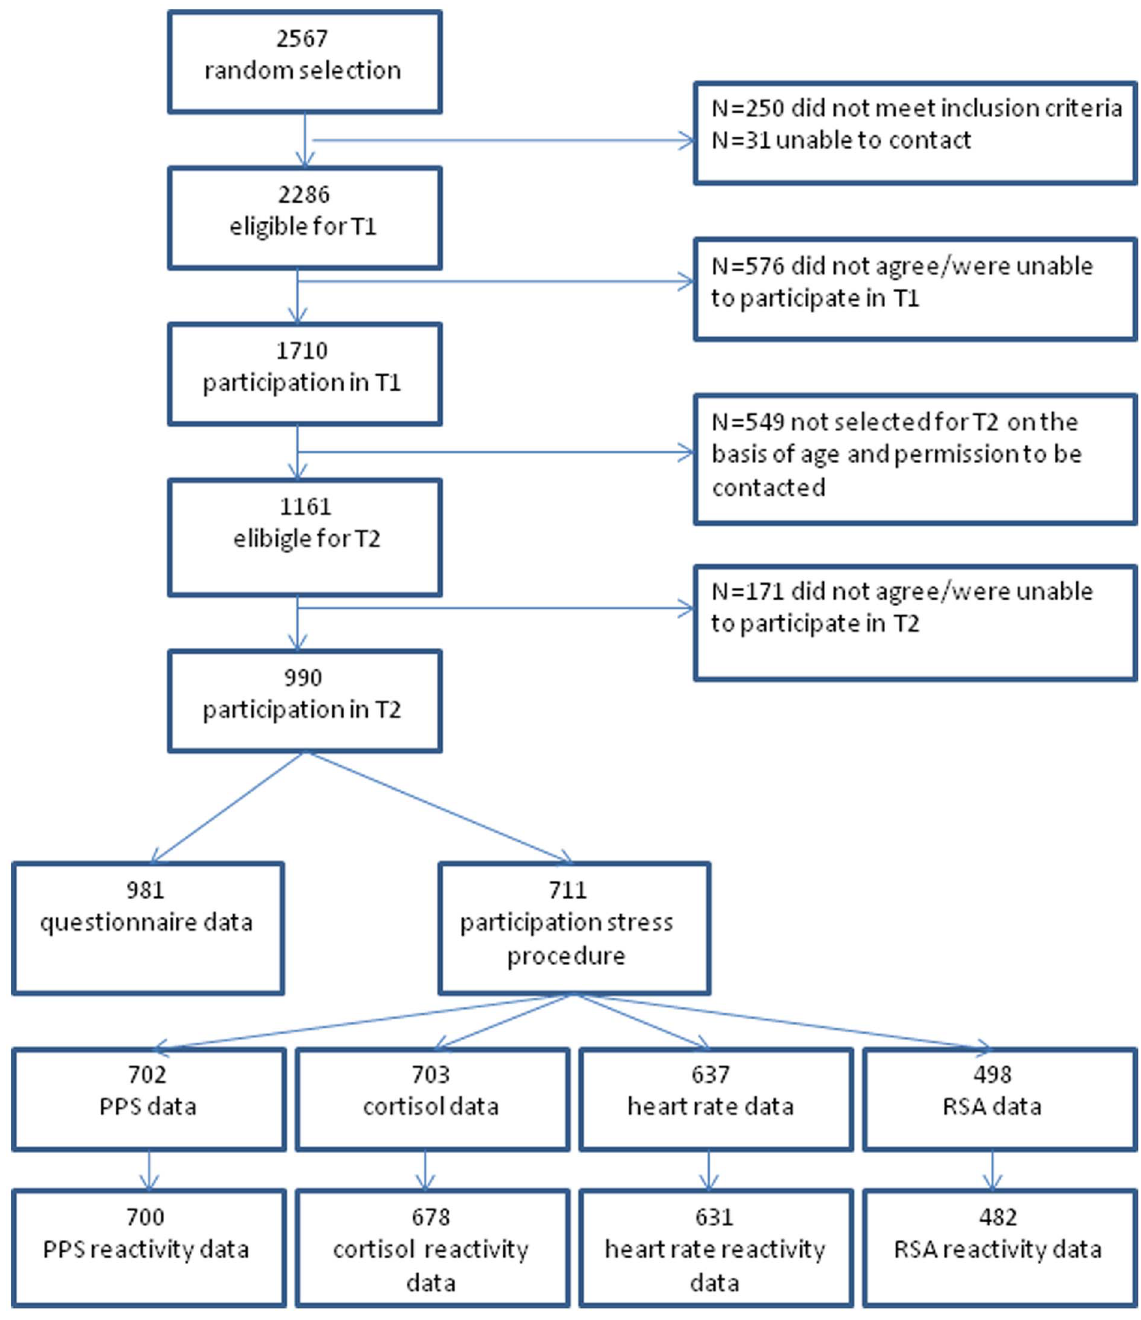
Figure 1. Flow-chart of available data. Notes. PPS=perceived physiological stress; RSA=respiratory sinus arrhythmia.